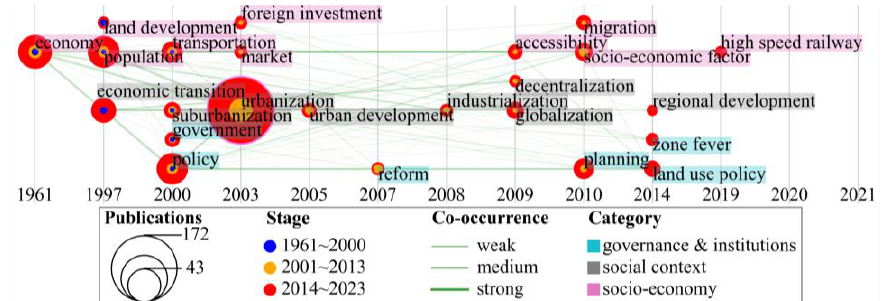
Figure 9. Development of themes indicating “driving factors”.